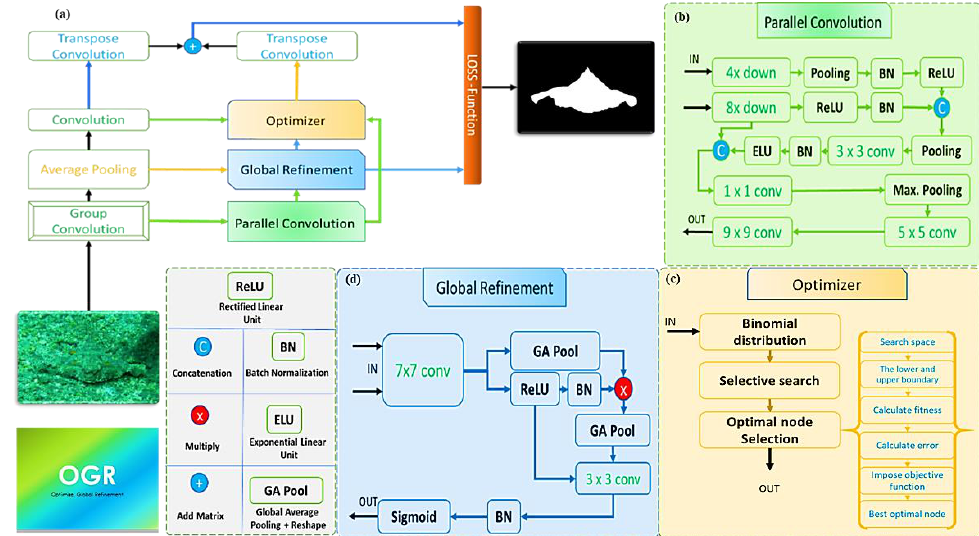
Figure 3. Optimize, Global Refinement Proposed Architecture: ( a ) Proposed Model; ( b ) Global Refinement; ( c ) Optimizer; ( d ) Parallel Convolution. Algorithm 1. Optimize, Parallel Refinement.